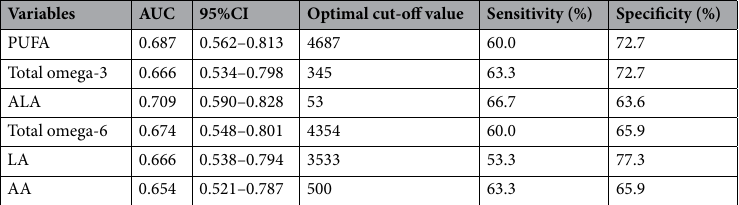
Table 4. Predictive value of six LCPUFA parameters in showing the risk of preterm birth.